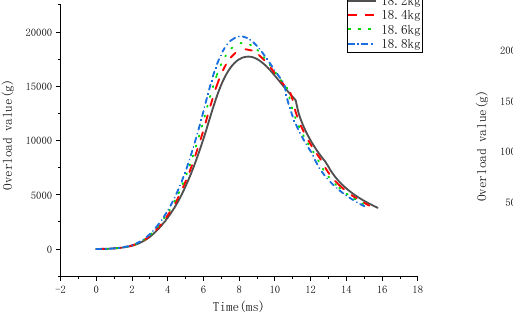
Fig. 2. a-t curves under different toyal charge mass.